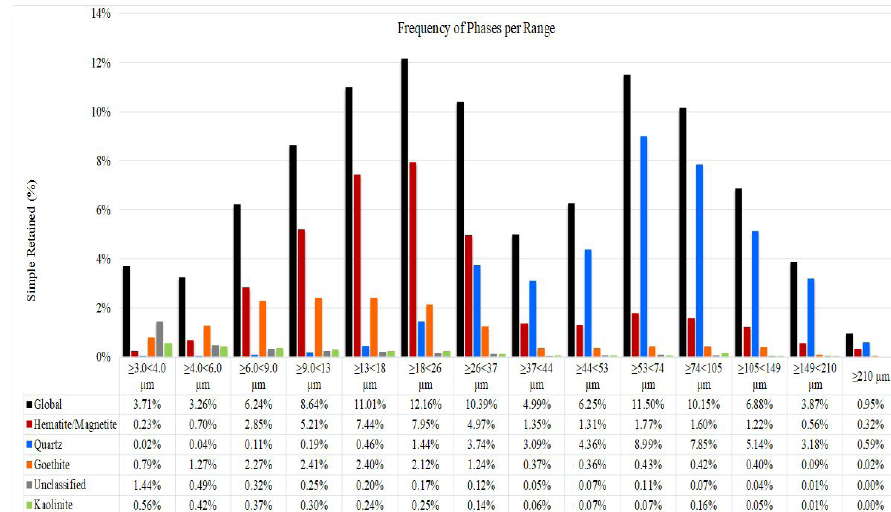
Figure 6. Frequency of mineral phases per